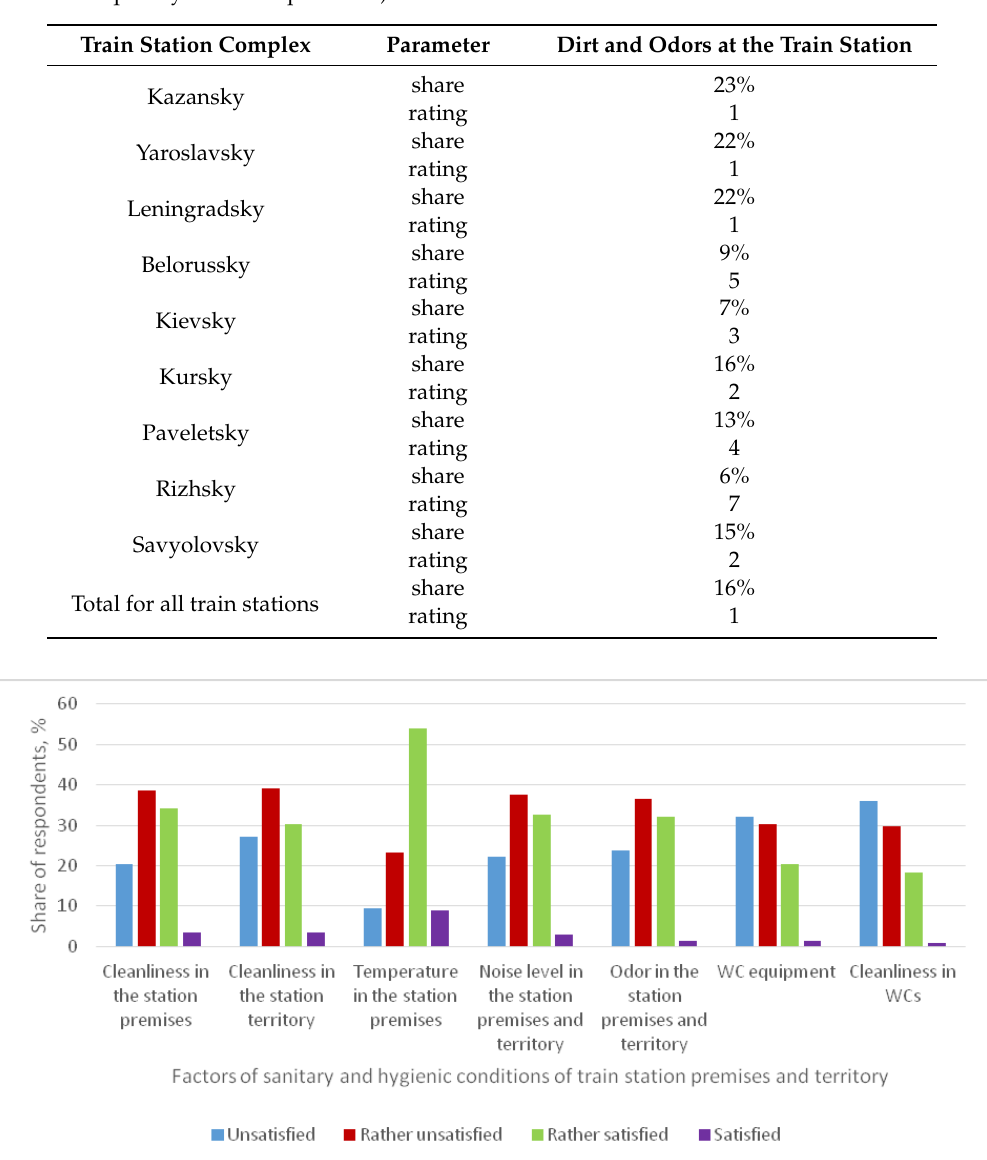
Table 1. Results of the analysis of the sanitary and epidemiological problems within the territory of Moscow train stations (share among the total number of complaints and appeals; rating among the 27 most frequently indicated problems).